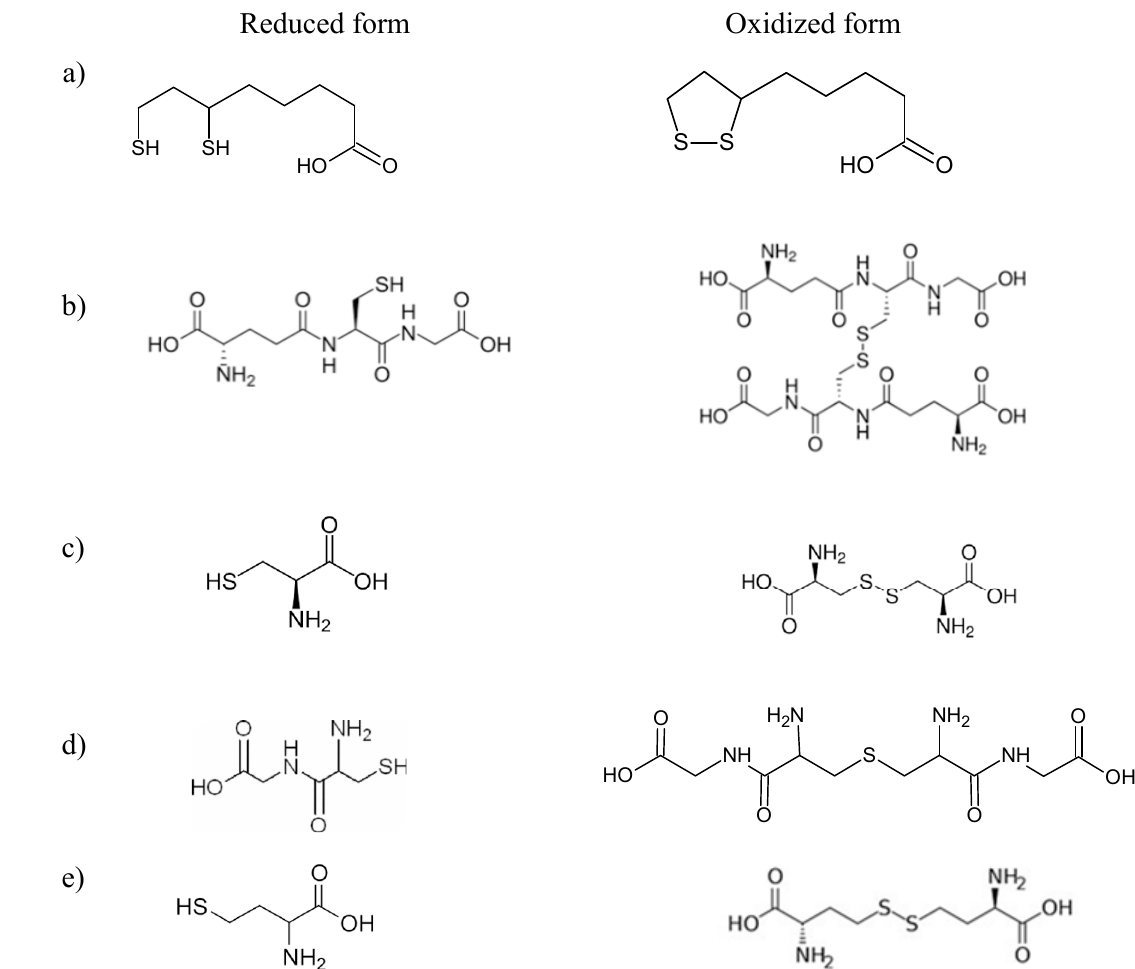
Figure 1. Chemical formulas of reduced and oxidative forms of some endogenous thiols: ( a ) dihydrolipoic acid and α -lipoic acid; ( b ) reduced glutathione and oxidized glutathione; ( c ) cysteine and cystine; ( d ) reduced cysteinylglycine and oxidized cysteinylglycine; ( e ) homocysteine and homocystine.